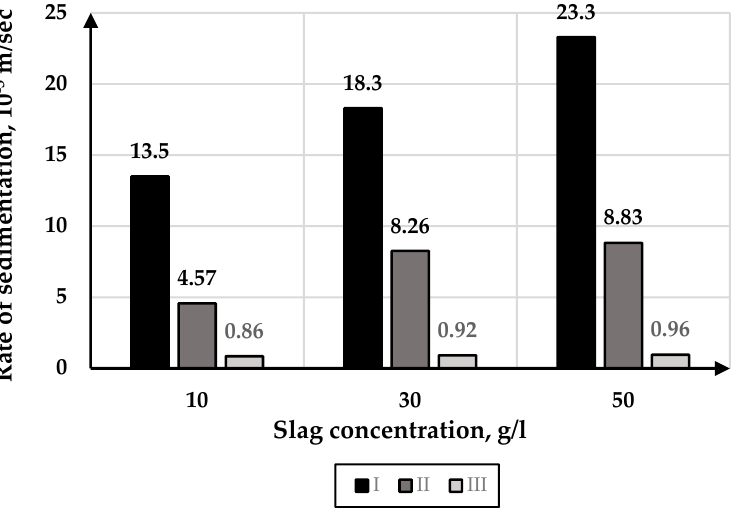
Figure 10. Dependence of the particle sedimentation rate on slag concentration after ultrasonic processing. Table 8. Comparison of slag particles sedimentation rates in water medium after ultrasonic processing and without it. Slag Concentration,